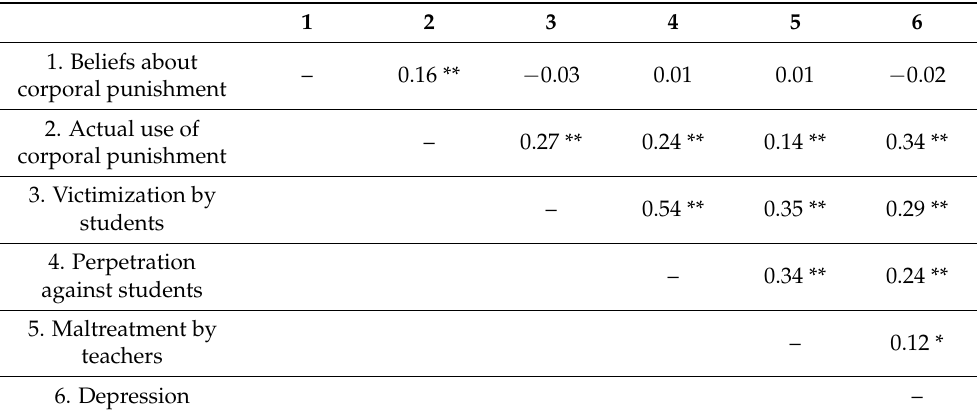
Table 2. Intercorrelations between variables in the